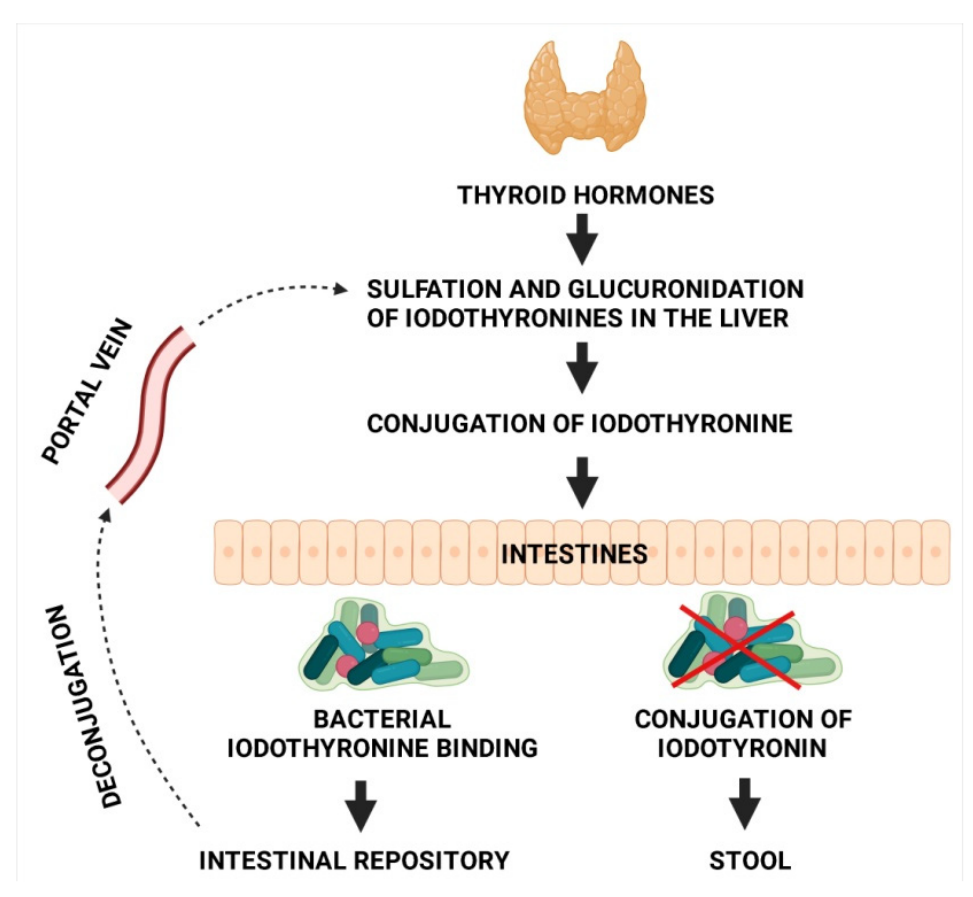
Figure 1. Hepato-intestinal circulation of iodothyronine (created with